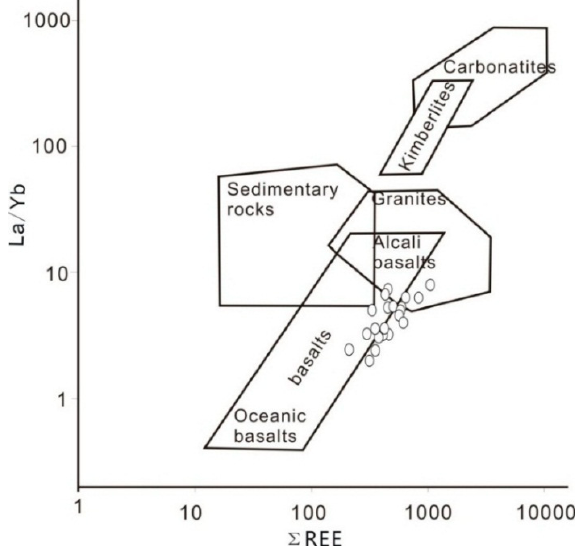
Figure 9. Relation between REE and La/Yb of tuff samples in the Zhongliangshan mine, Chongqing.